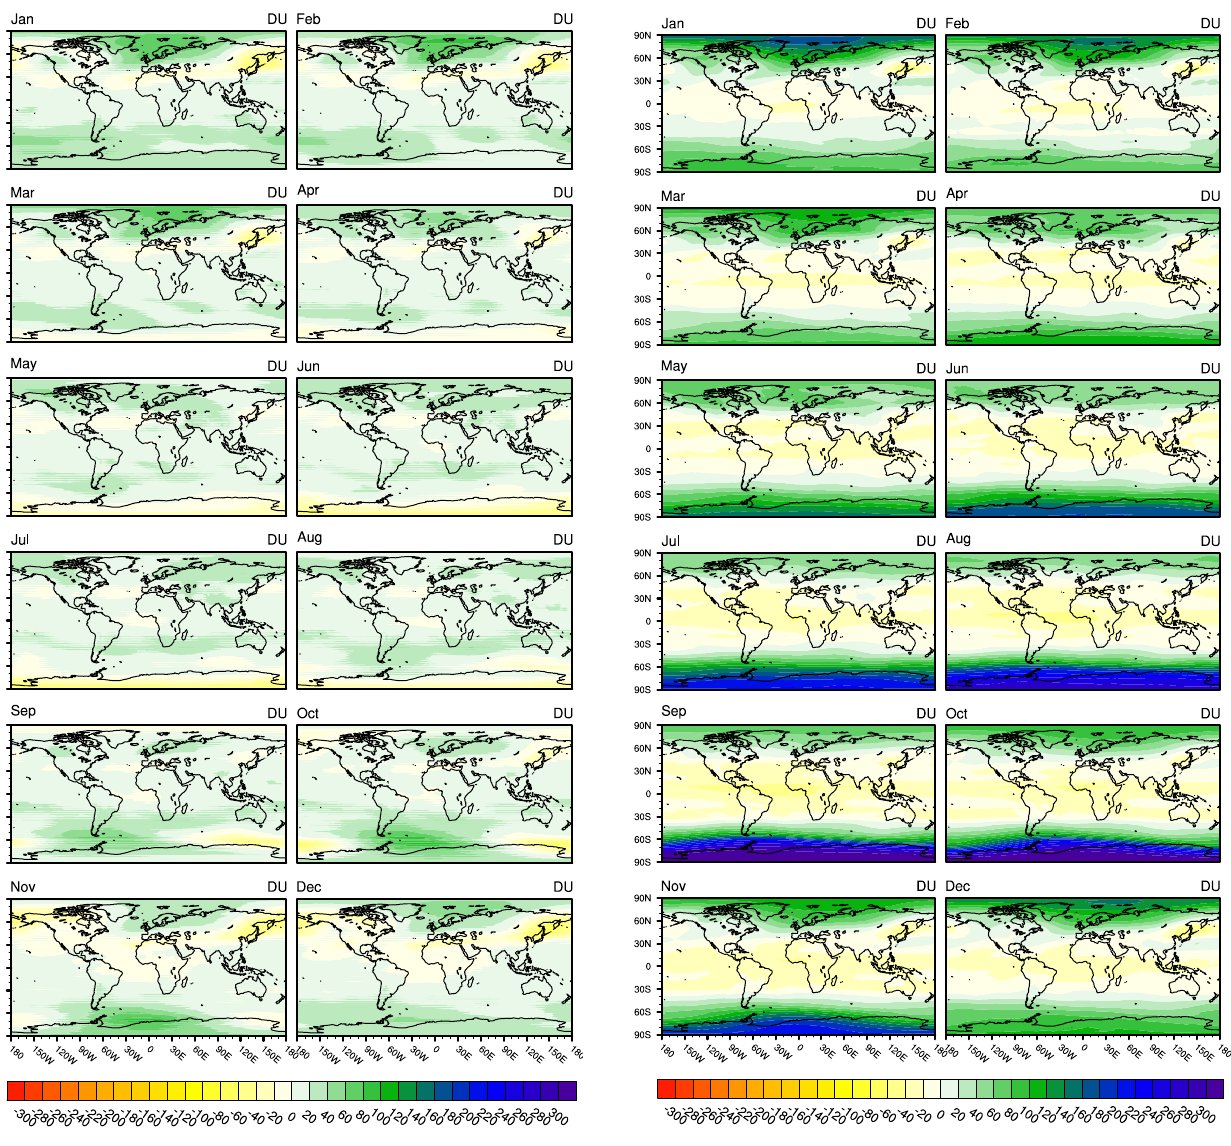
Figure 6. Bias in the total ozone column using the MSR monthly averages for the period (1979–2008) as a baseline for CAM.